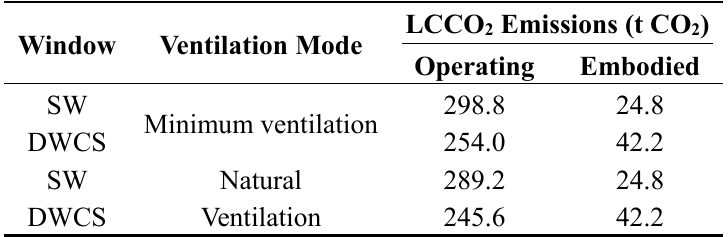
Table 14. Calculated LCCO 2 emissions.